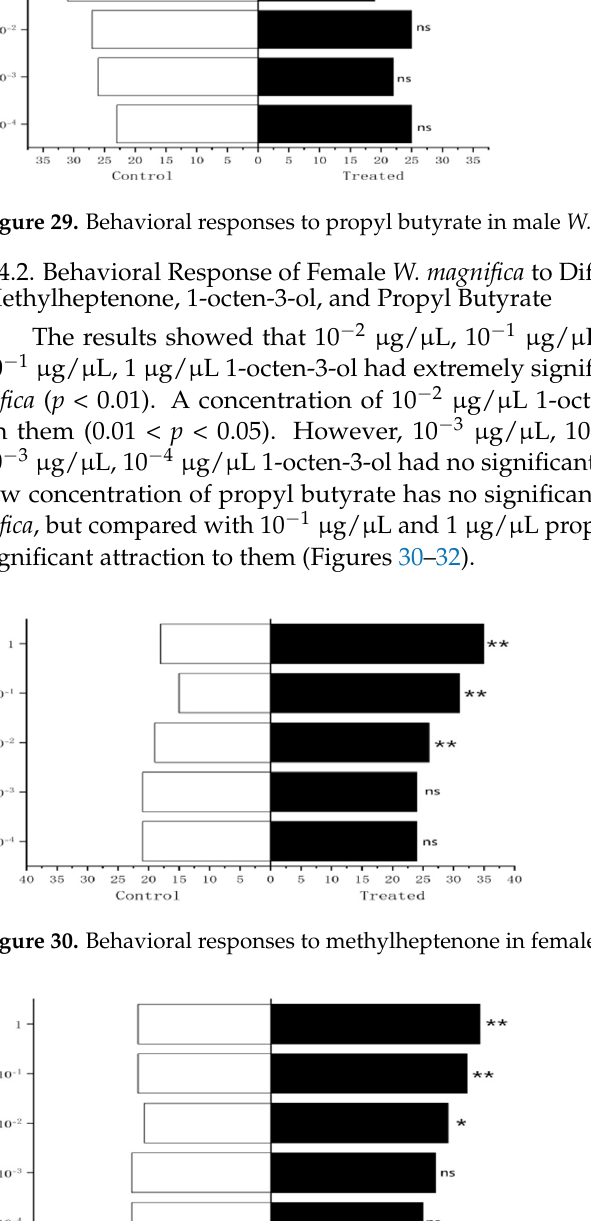
Figure 29. Behavioral responses to propyl butyrate in male W. magnifica .